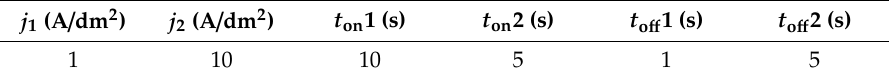
Table 1. Optimal deposition